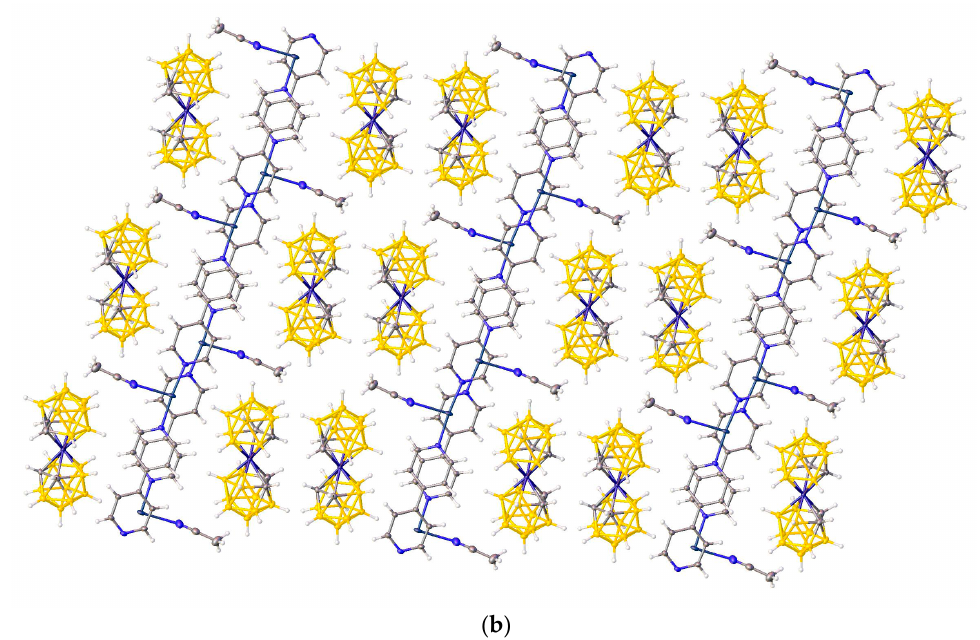
Figure 109. X-ray structure of {(Ag(4,4’-Bipy)(MeCN))[3,3’-Co(1,2-C 2 B 9 H 11 ) 2 ]} n : coordination arrangement of silver cation ( a ) and crystal packing ( b ).